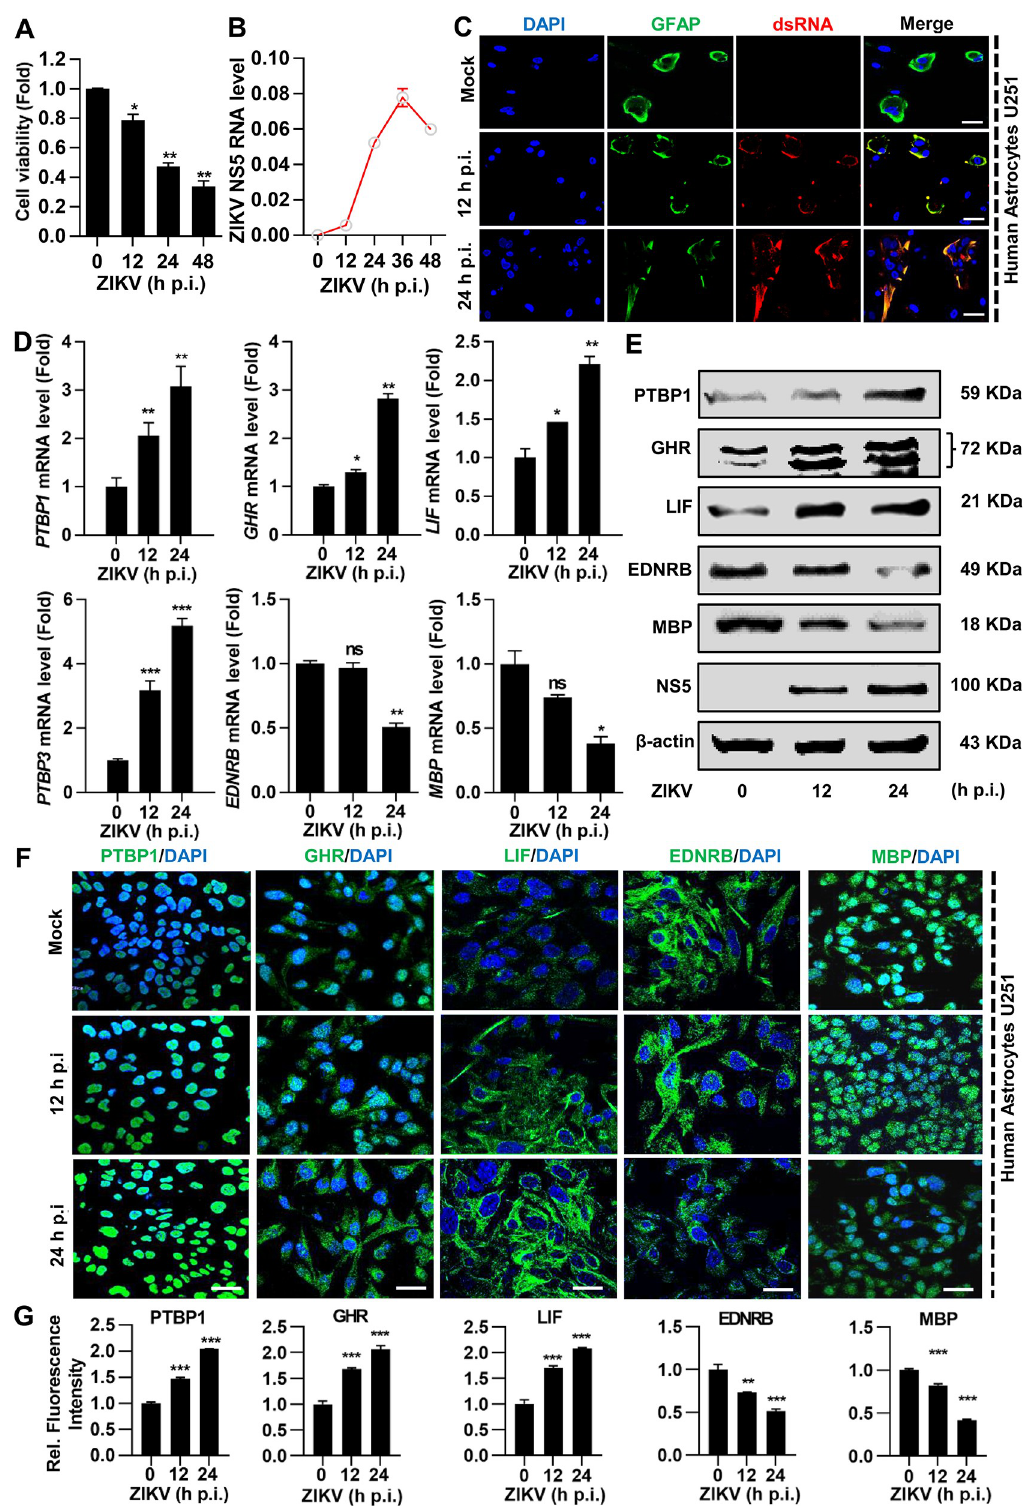
Fig 6. ZIKV infection differentially alters certain astrocytic genes in U251 cells. U251 cells were infected with ZIKV at MOI of 2 for indicated periods. (A) Cell viability was measured by the CCK-8 assay. Data represent as fold change compared to mock-treated cells. (B) ZIKV NS5 RNA was determined by qPCR with GAPDH as an internal control, and (C) viral dsRNA was